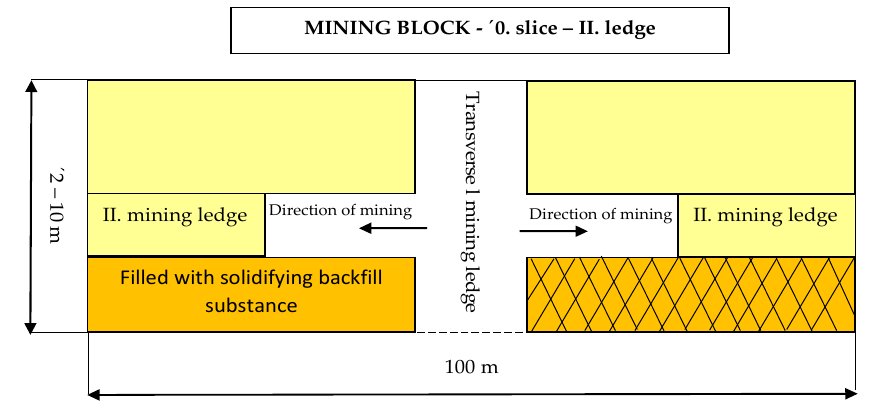
Figure 5. The procedure of excavating of a mining block.